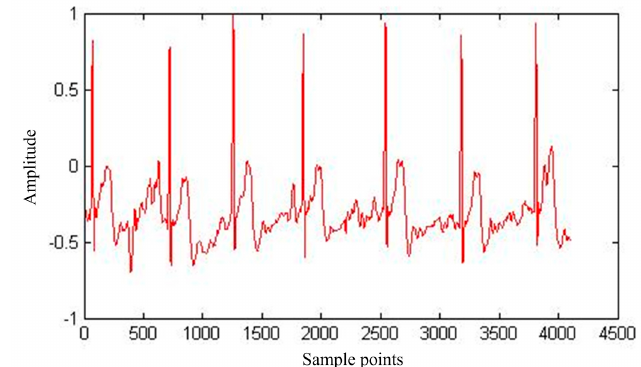
Figure 3. ECG signals with no interference.